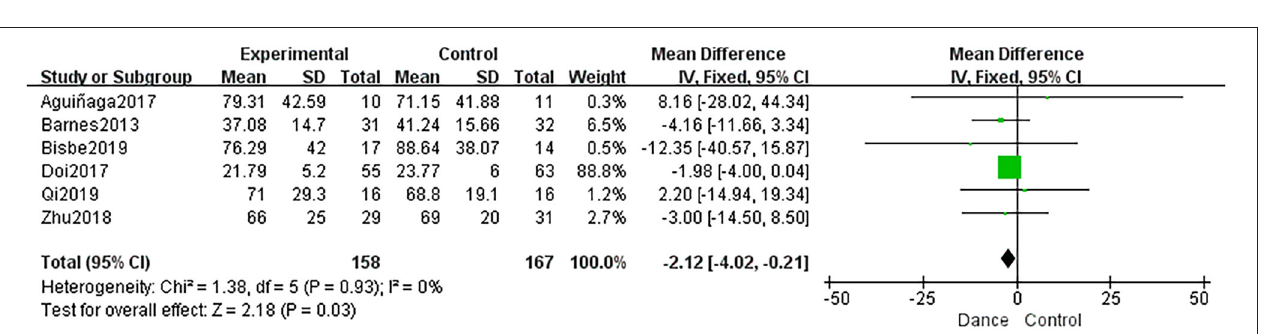
FIGURE 5 | Forest plot of rote memory results of dance group vs. control